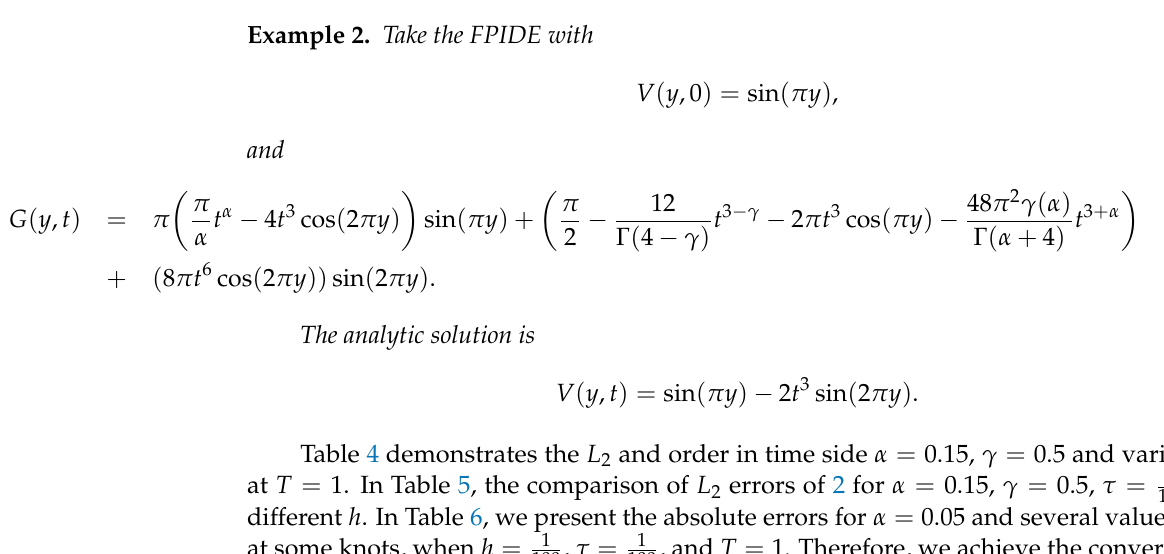
Table 4. The L 2 errors of Example 2 for α = 0.15, h = 1